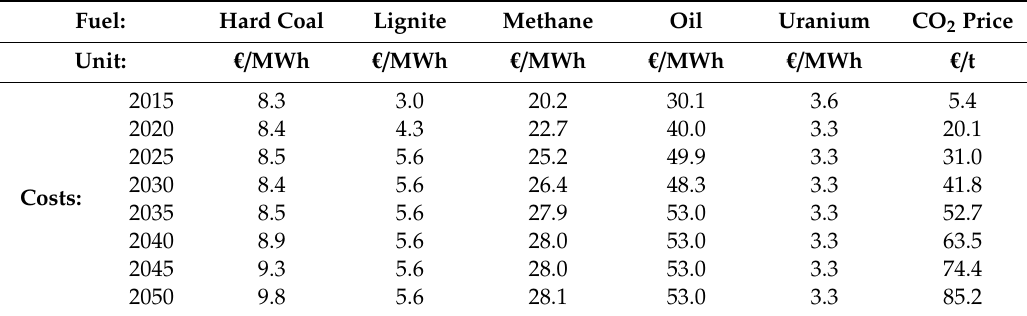
Table A1. Costs (real) of fuels (net calorific value) and prices of CO 2